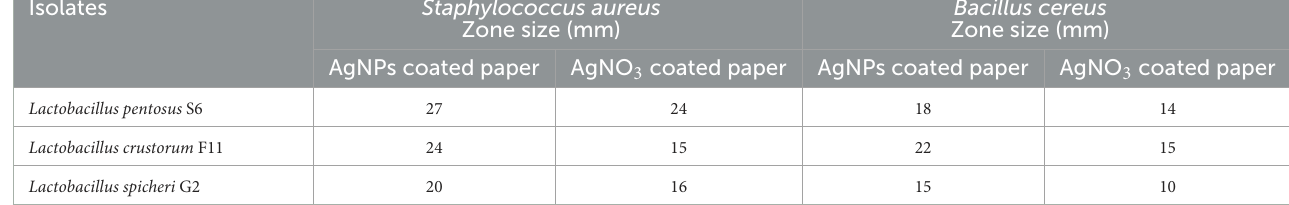
TABLE 2 Antibacterial activity of bacteriocin synthesized silver nanoparticles coated paper. Isolates